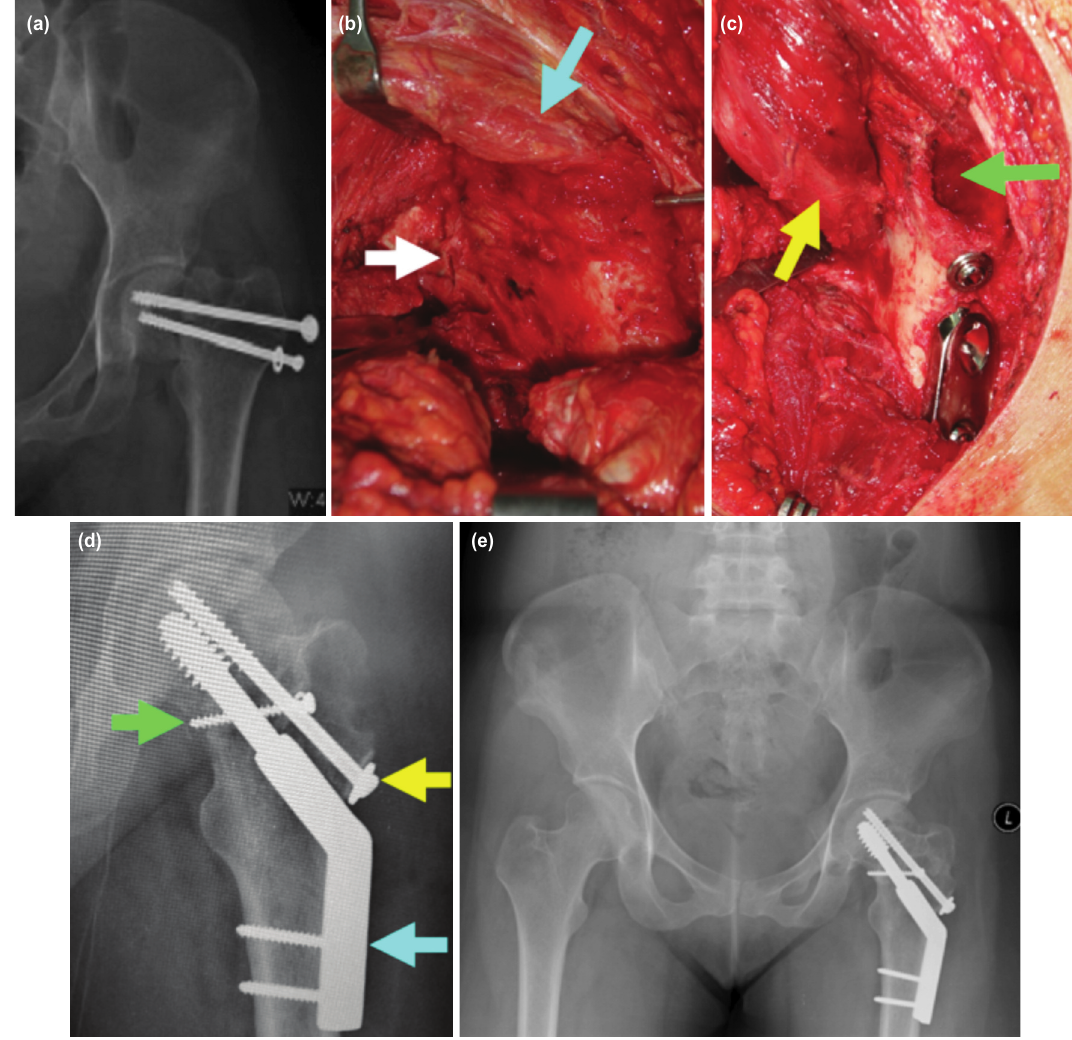
(a) Photos showing the initial screw fixation of case no. 2 with non-union of the femoral neck, varus deformity and neck Fig. 1: shortening, (b) open reduction thru Watson Jones approach, anterior one-third of the gluteus medius (blue arrow), reduction of the neck fracture (white arrow), correction of the varus deformity and the neck length, (c) myo-osseous trochanteric flap transferred to the non-union site (yellow arrow), additional bone graft needed was harvested from the trochanter underneath the osteotomised osseous flap (green arrow), (d) post-operative radiograph showing satisfactory reduction and correction maintained with sliding compression screw (blue arrow) and anti-rotational screw (yellow arrow), one cancellous screw (green arrow) secured the myo-osseous flap at the non-union site, (e) radiograph seven years post-surgery with union of the femoral neck without evidence of